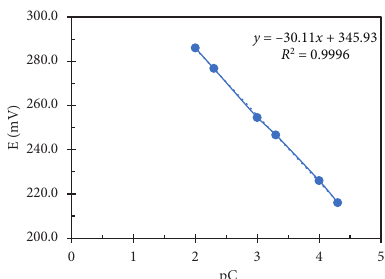
Figure 9: Potentiometric linearity profile of DES.RNK graphite sensor.